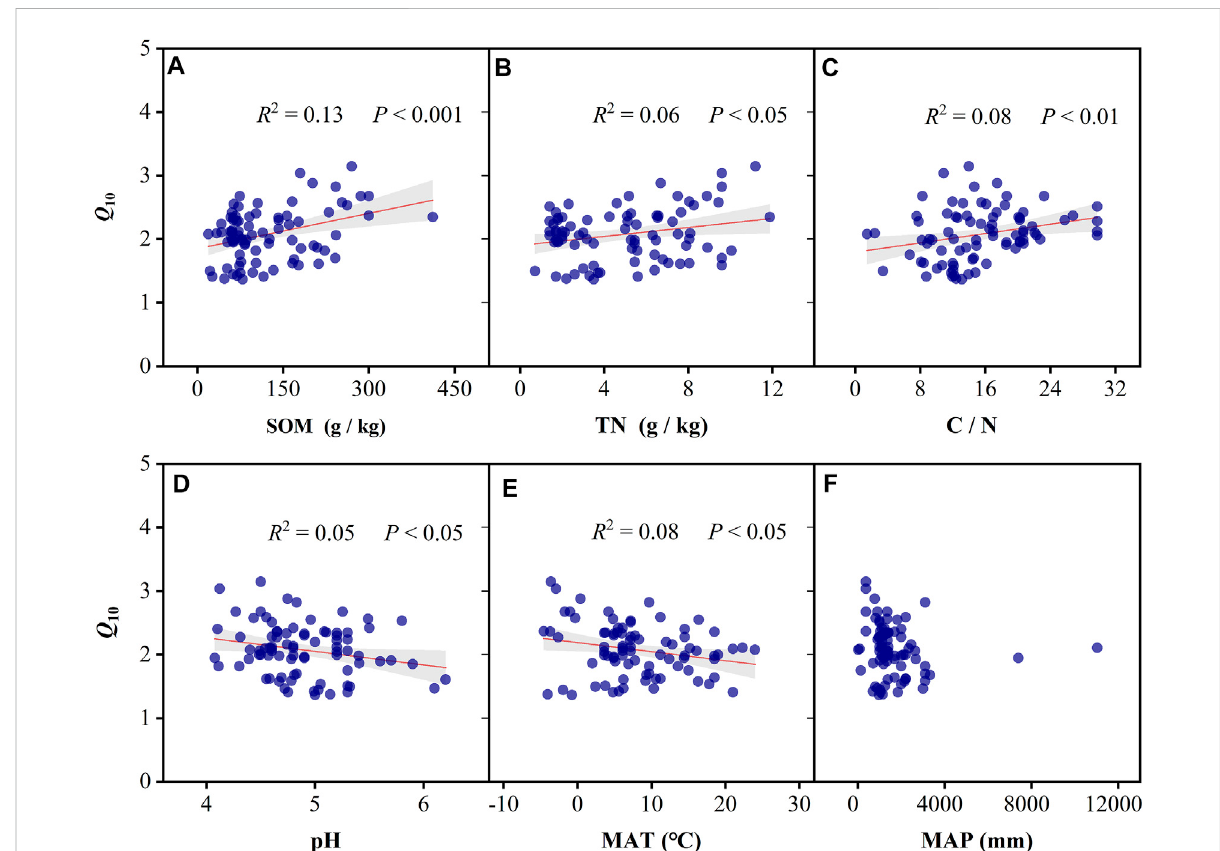
FIGURE 5 Q 10 value of soil respiration in relation to soil properties and climatic factors on a global scale ( SOM, TN, C/N, pH, MAT, and MAP, respectively. SOM, soil organic matter; TN, total nitrogen; C/N, ratio of carbon and nitrogen; MAT, mean annual temperature; MAP, mean annual precipitation. Shaded areas indicate the 95% con fi dence